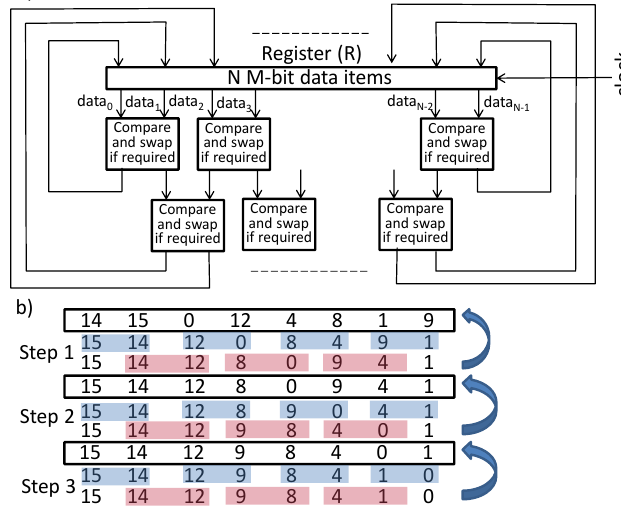
Fig. 1. Sorting network with sequentially invoked even-odd comparators (a); an example (b).